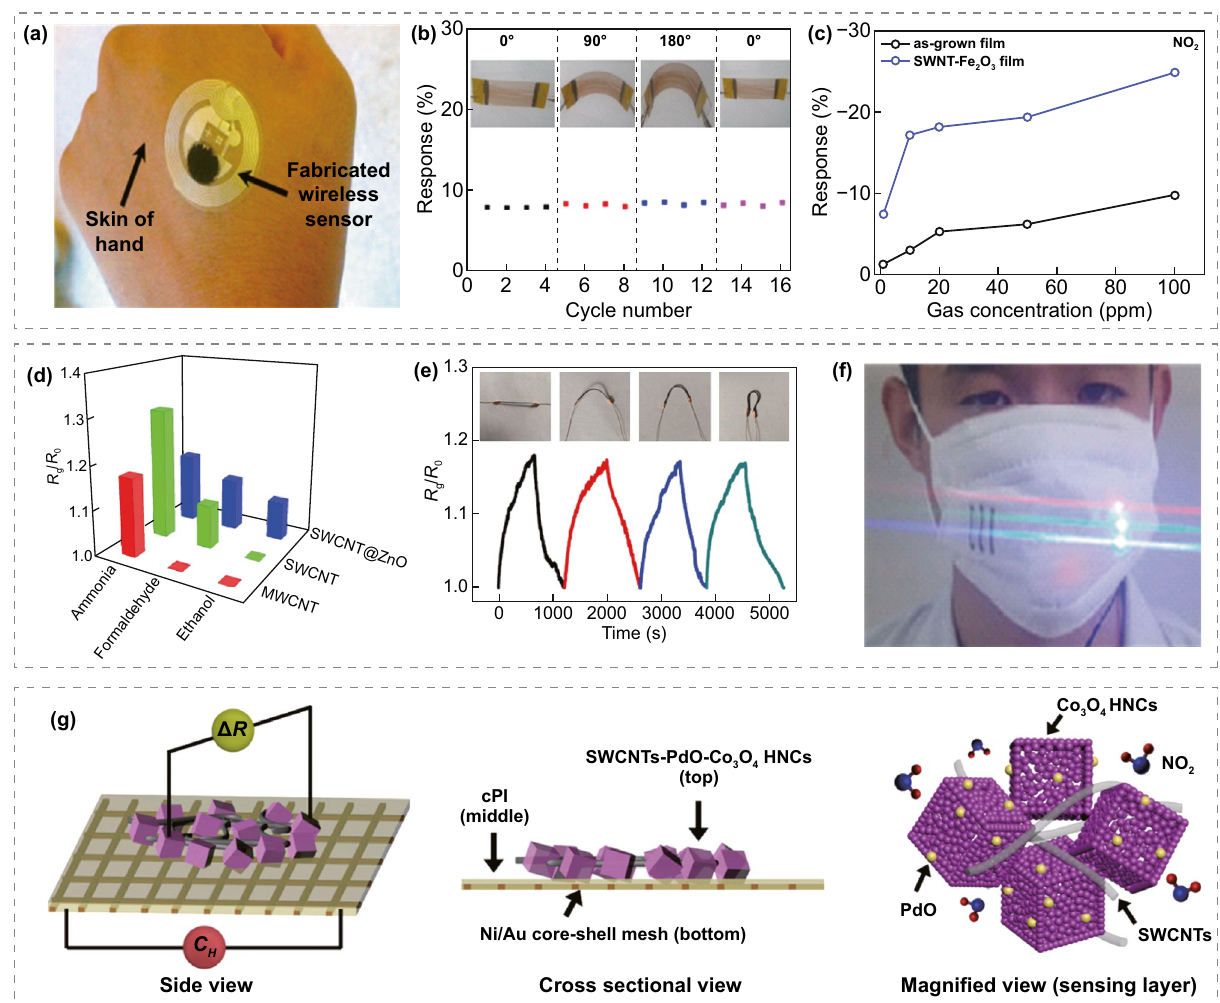
Fig. 5 a The optical image of manufactured wireless RFID sensor. Reproduced with permission from Ref. [112]. Copyright (2016) Elsevier. b Response of Fe 2 O 3 ‑SWCNTs sensor under large‑degree deformation. c Response of SWCNTs and Fe 2 O 3 ‑SWCNTs sensor towards NO 2 (1, 10, 20, 50, and 100 ppm). Reproduced with permission from Ref. [68]. Copyright ( 2017 ) Elsevier. d Response of the SWCNT, MWCNT and SWC‑ NTs@ZnO nylon sensors to 500 ppm NH 3 , HCHO and C 2 H 5 OH at RT. e Response of the nylon‑based sensor under large‑degree deformation. f The optical image of a multifunctional mask with integrated NH 3 , HCHO and C 2 H 5 OH sensors. Reproduced with permission from Ref. [100]. Copyright ( 2018 ) Springer Nature. g Schematic illustrations of SWCNT/PdO/Co 3 O 4 on flexible Ni/Au‑PI film. Reproduced with permission from Ref. [74]. Copyright ( 2017 ) American Chemical